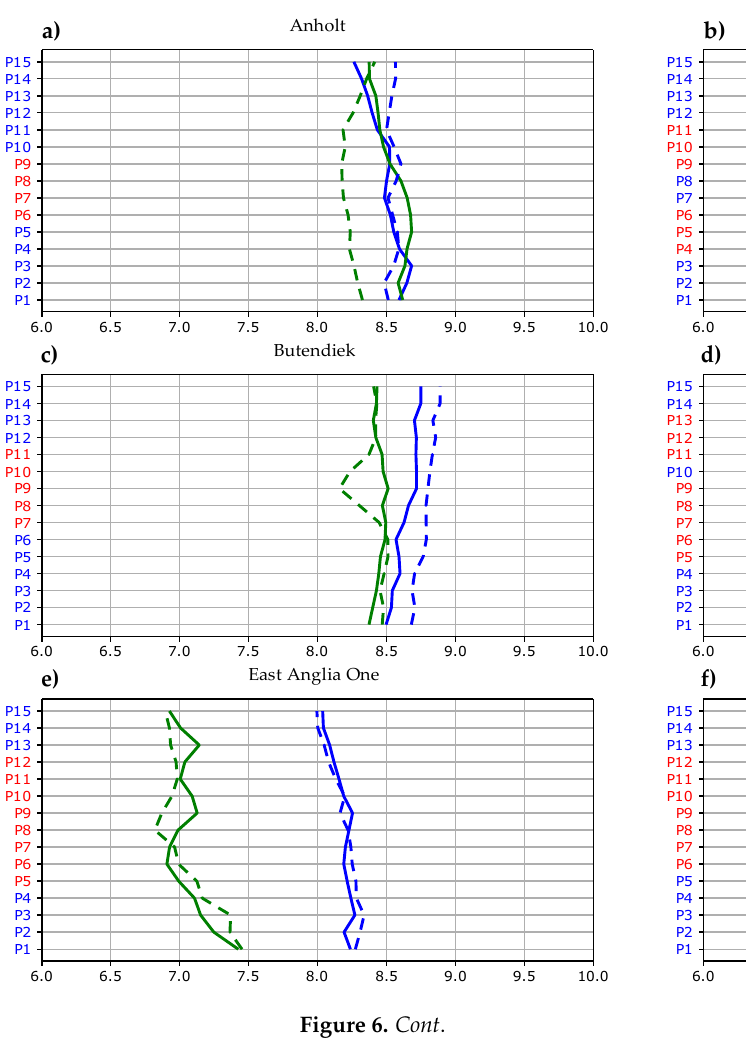
Figure 6. Mean wind speed ( 𝑈) for easterly winds over the OWFs and clusters. See Figure 4 for the line definitions. ( a ) Anholt; ( b ) Horns Rev cluster; ( c ) Butendiek; ( d ) Nordsee cluster; ( e ) East Anglia One; ( f ) Global Tech cluster; ( g ) Greater Gabbard & Galloper; ( h ) Hornsea Project One.